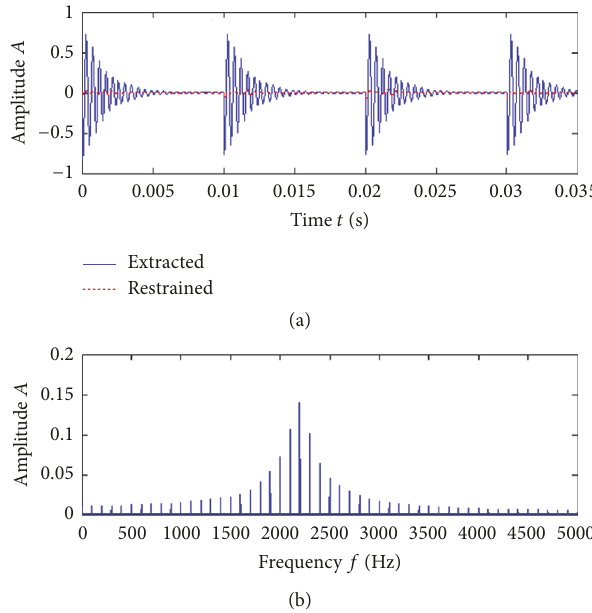
Figure 5: Bearing fault signal extraction result of CTH: (a) time domain waveform and (b) FFT